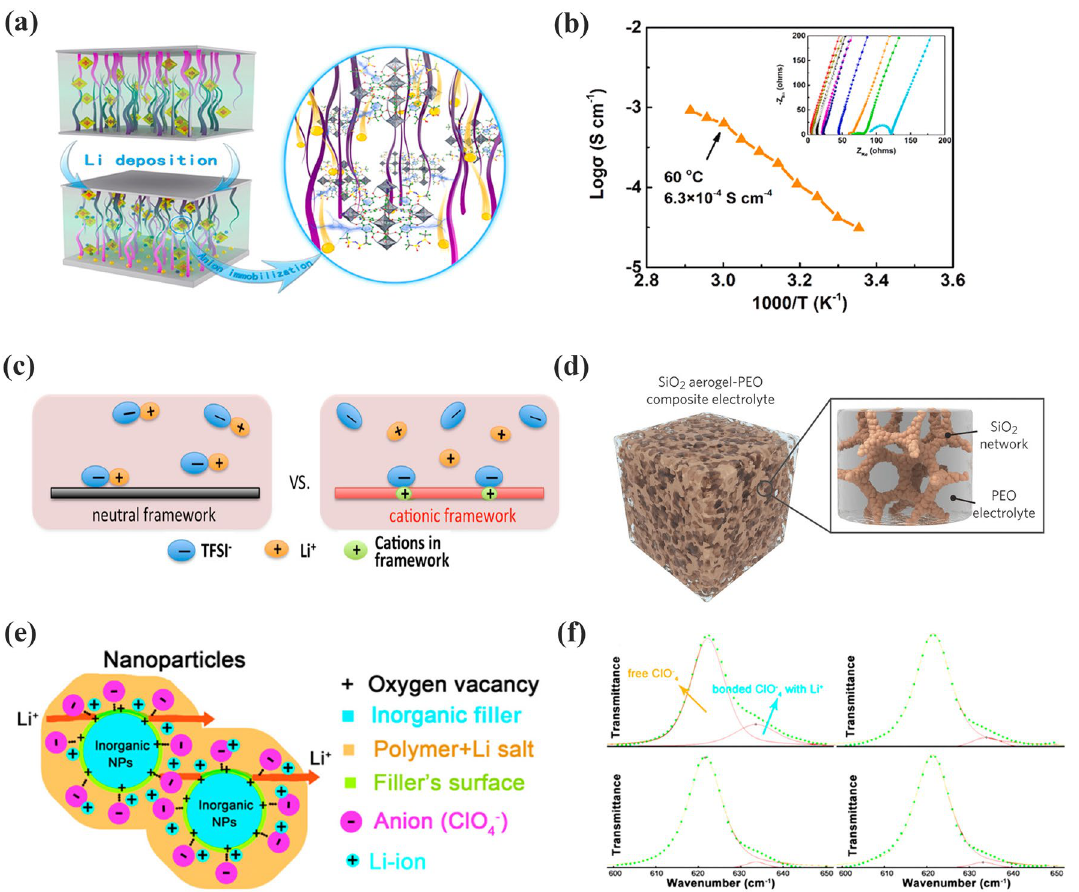
Fig. 9 a Schematic diagram of Li-ion transport in CMOF; b the ionic conductivities of P@CMOF with different temperature. Adapted with permission from Ref. [128]. c Schematic illustrations of ion association in COFs with neutral and cationic frameworks, respectively. Adapted with permission from Ref. [129]. d LiTFSI was dissolved in PEGDA/SCN and SiO 2 aerogel is the backbone. Adapted with permission from Ref. [115]. e Schematic of lithium-ion transport in YSZ; f FTIR spectra from filler-free electrolyte to the 2–7 mol% YSZ. Adapted with permission from Ref.